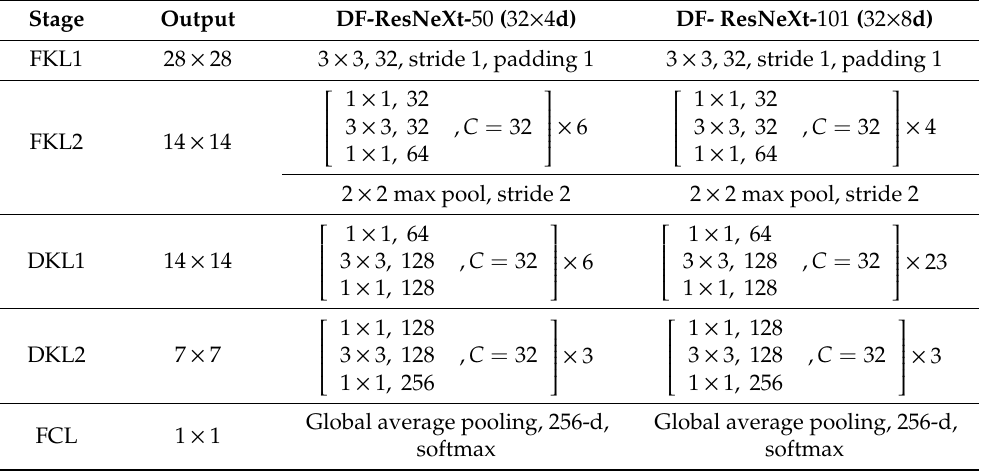
Table 2. Detailed structure of the subframe of